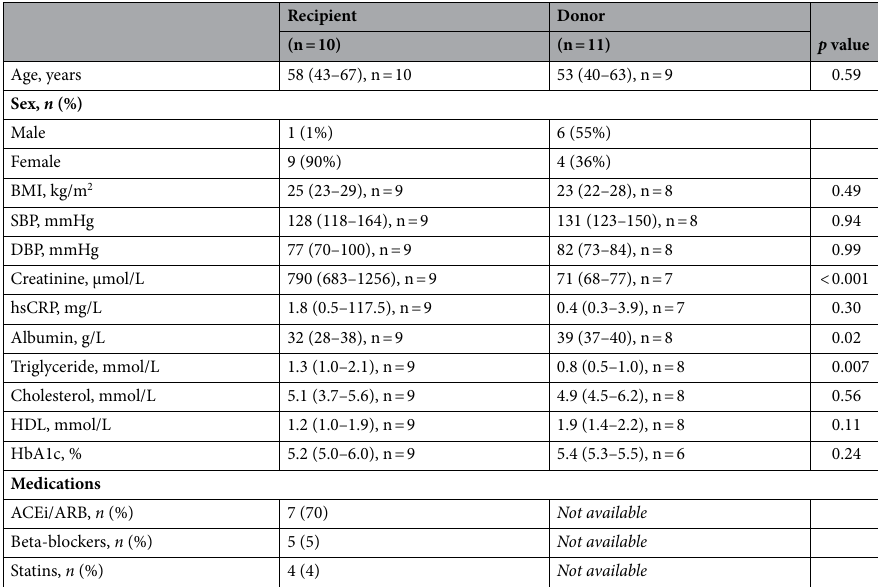
Table 2. Clinical characteristics of kidney transplant patients and donors used for immunohistochemistry investigations. Data are presented as median and quartile range (Q1-Q3). Categorical data are presented as frequency (%). Continuous data analysed by non-parametric Mann–Whitney U test. BMI body mass index, SBP systolic blood pressure, DBP diastolic blood pressure, hsCRP high sensitivity C-reactive protein, HDL high density lipoprotein, LDL low density lipoprotein, HBA1c glycated haemoglobin, IL interleukin, ACEi/ARB angiotensin converting enzyme inhibitor/angiotensin receptor